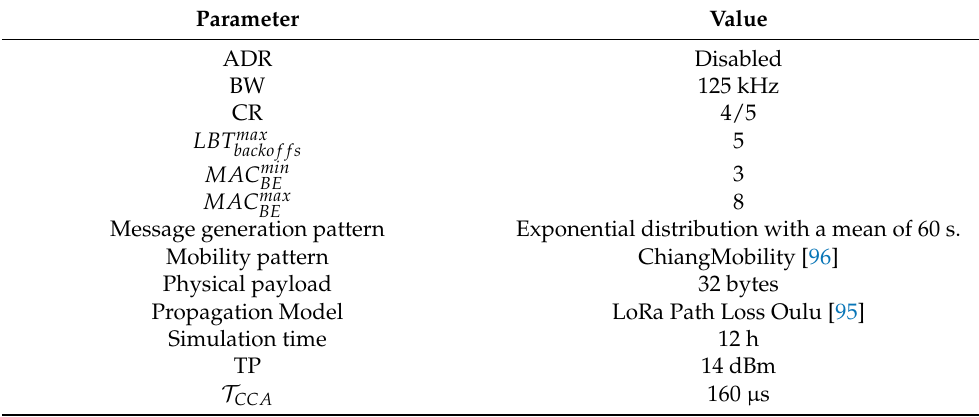
Table 5. Simulation parameters.